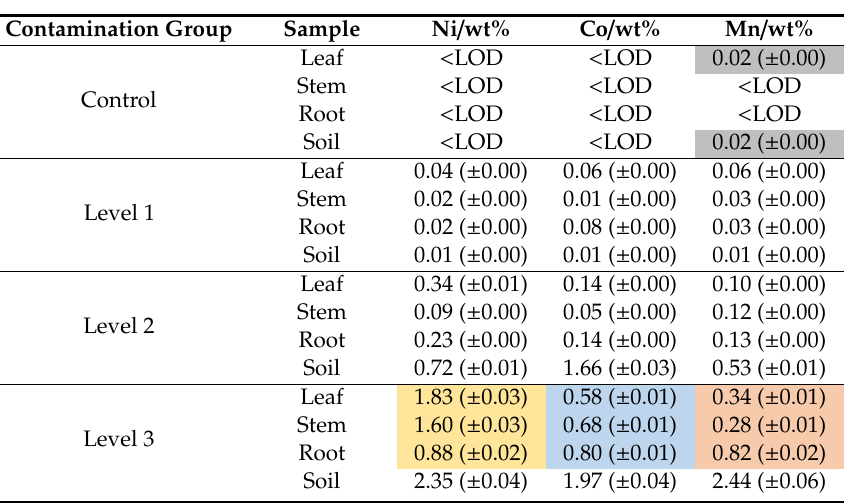
Table 1. Concentrations of Ni, Co, and Mn (wt%) in di ff erent organs after 20 days of contamination with defined amounts of Ni, Co, and Mn of A. murale by means of ICP-OES regarding dry matter and dried soil. Highest concentrations in plants for the respective metals are indicated with di ff erent colors, and the natural occurrence of Mn in the control group is depicted in grey (n =